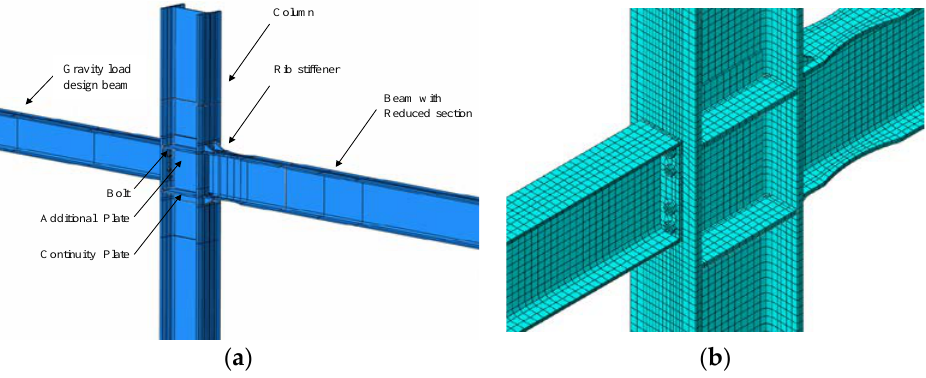
Figure 4. Main features of the FE model: geometry ( a ) and mesh ( b ).